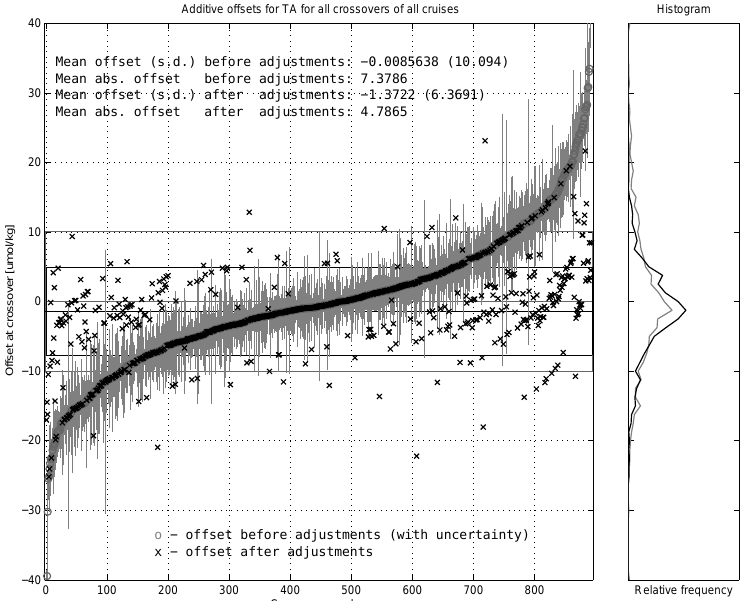
Figure 7. Figure showing the o ff sets for individual crossovers for alkalinity as determined by the cnaX routine. The gray circles are the o ff sets before adjustment; black crosses the o ff sets after application of the adjustments suggested by the inversion that are larger than the threshold value. Both sets of o ff sets are sorted independently of each other, but the uncertainty of the crossovers is only shown for the uncorrected crossovers. The right panel shows the relative distribution of o ff sets (gray line before adjustment; black line after adjustment). This analysis includes also the GLODAP reference cruises.